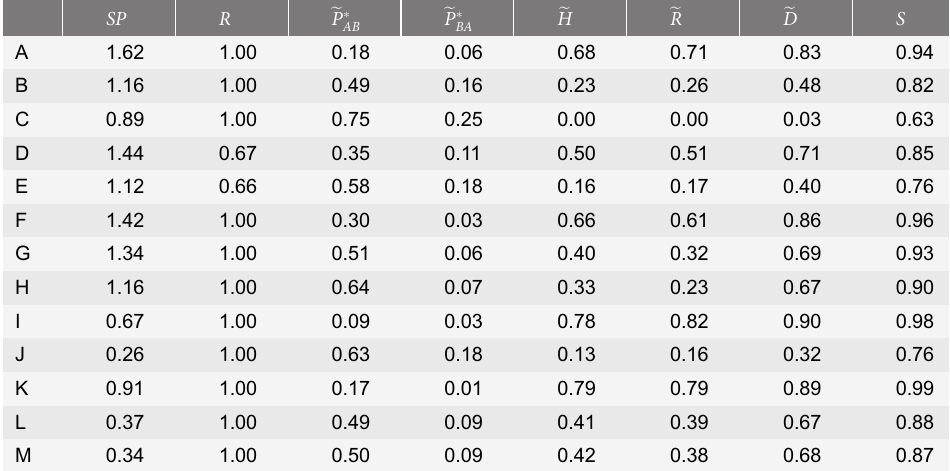
e P (cid:2) AB is the exposure of the minority group (i.e., the black cells in the figures) to the majority group (i.e., the white cells), and e P (cid:2) is that of the majority group to the minority group. All calculations were done with default BA settings, except that KDE was used for the spatial segregation measures. The results are rounded to the second decimal place.